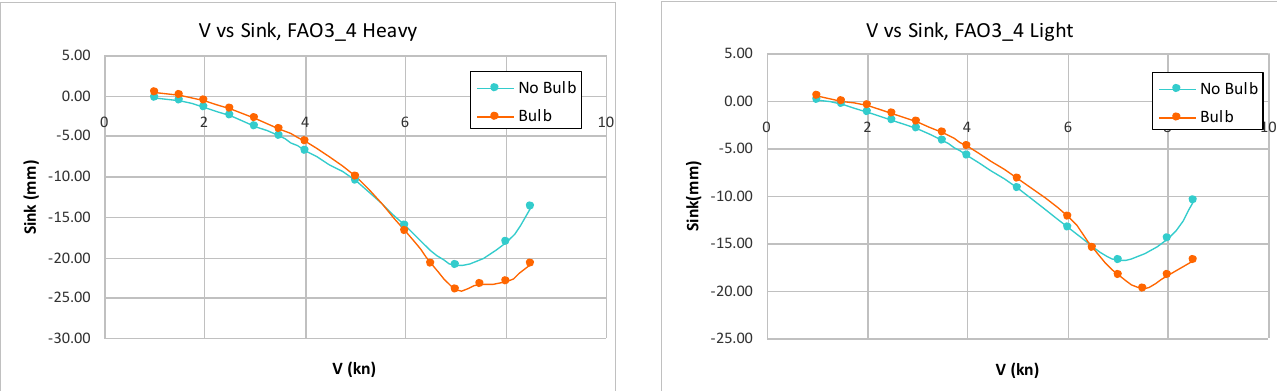
Figure 23. Effect on sinkage, FAO1 vs. FAO2.